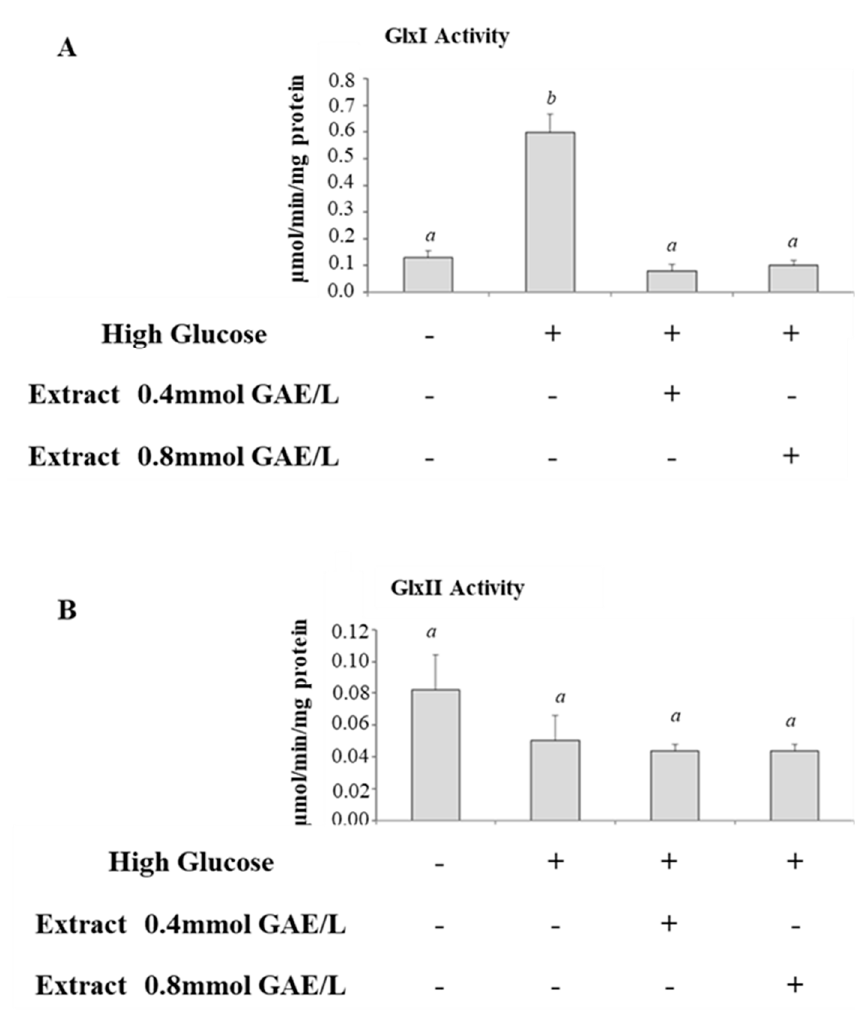
Figure 3. The glyoxalase system in HG-treated CaCo-2 cells incubated in the absence or in the presence of apple polyphenolic extract. ( A ) Glx I and ( B ) Glx II activity in intestinal CaCo-2 cells treated for one week with normal (25 mM) (Ctrl), or with high glucose (50 mM) concentrations in the absence (HG) or in the presence of polyphenolic extract (0.4 and 0.8 mmol GAE/L). Results are presented as mean ± SD of 5 determinations carried out in triplicate. Different letters a,b indicate significant statistic differences between samples ( p < 0.05).